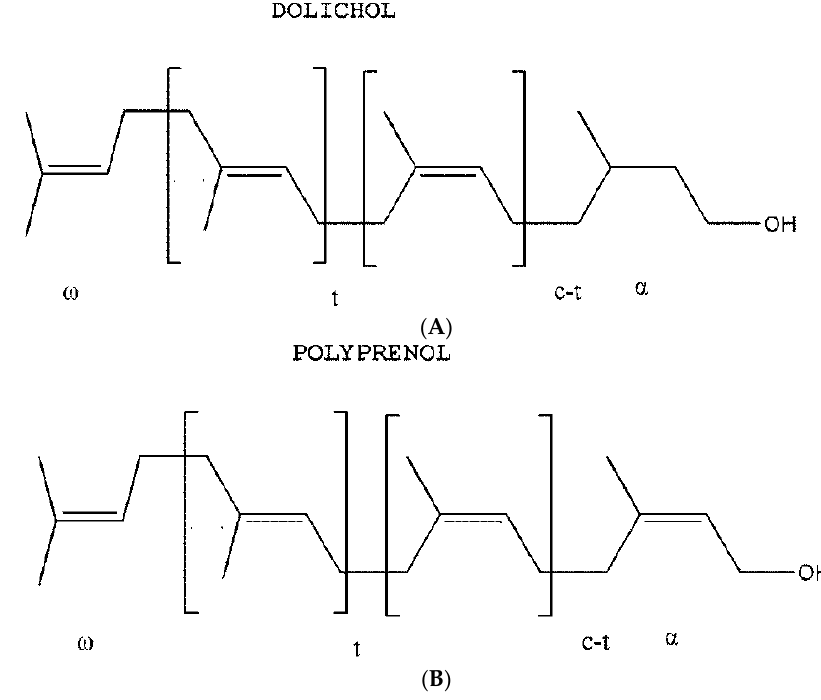
Figure 1. Chemical structure of dolichols and polyprenols of Ginkgo biloba leaves. ( A ) Dolichols; ( B ) Polyprenols of Ginkgo biloba L. (GBP).